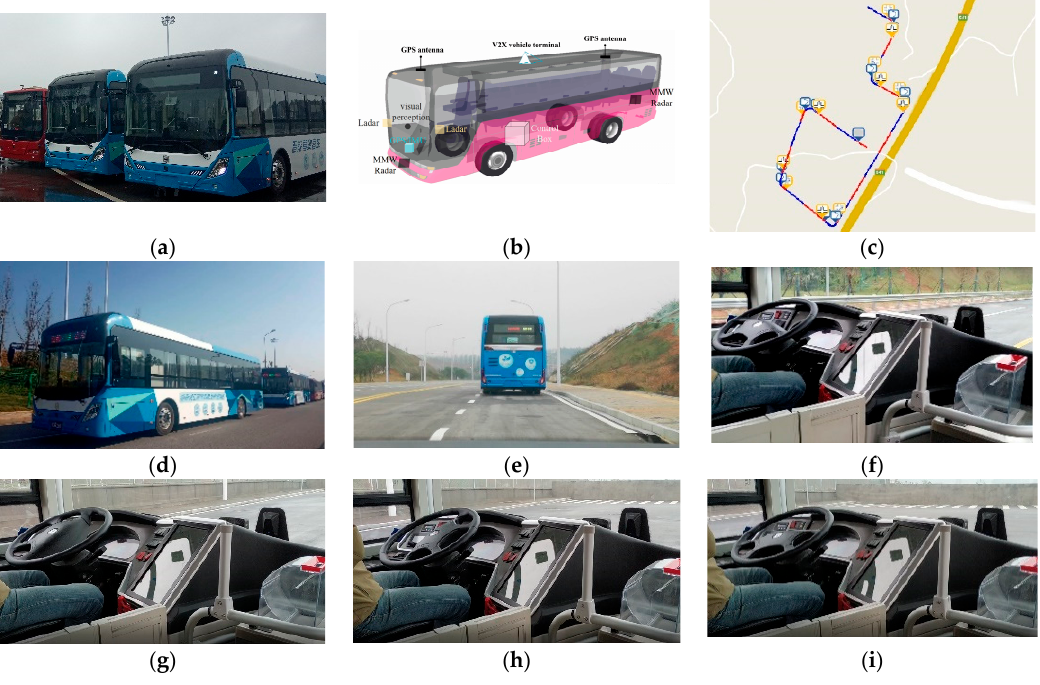
Figure 8. Real vehicle test platform and process.